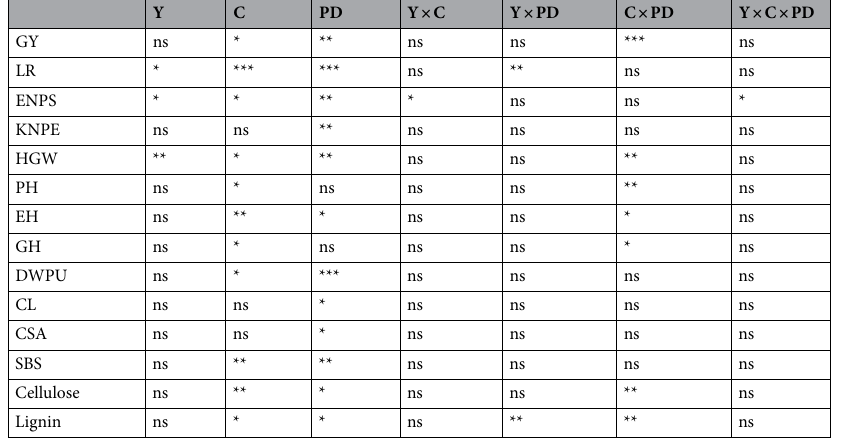
Table 1. Output of three-way ANOVA on the effects of the year (Y), Hybrid (H), planting density (PD), and their interactions. GY, grain yield; LR, lodging rate; ENPS, ear number per ha; KNPE, kernel number per ear; HGW, 100-grain weight; PH, plant height; EH, ear height; GH, gravity height; DWPU, dry weight per unit length; CL, culm length; CAS, stem cross-section area; SBS, stem bending strength; Cellulose, cellulose content; Lignin, lignin